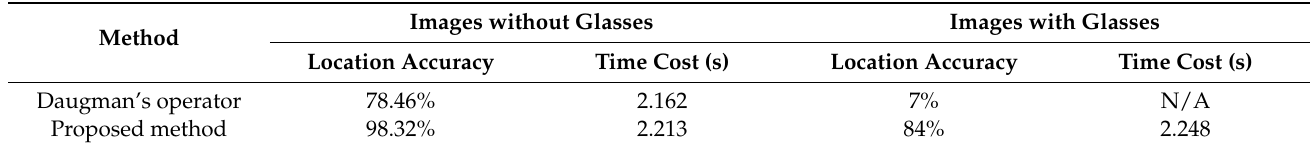
Table 3. Comparison results of iris localization at a short distance.